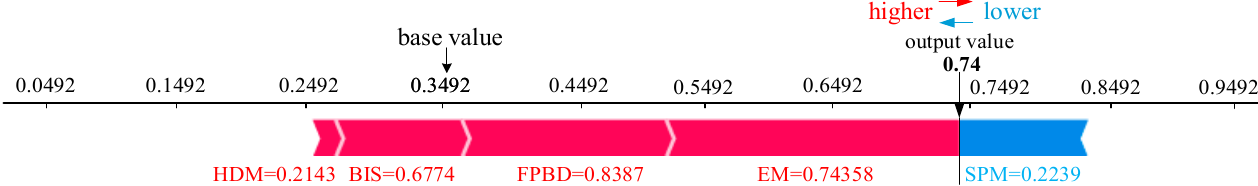
Figure 4. Importance factor of each input variable for fire risk database of stadiums.